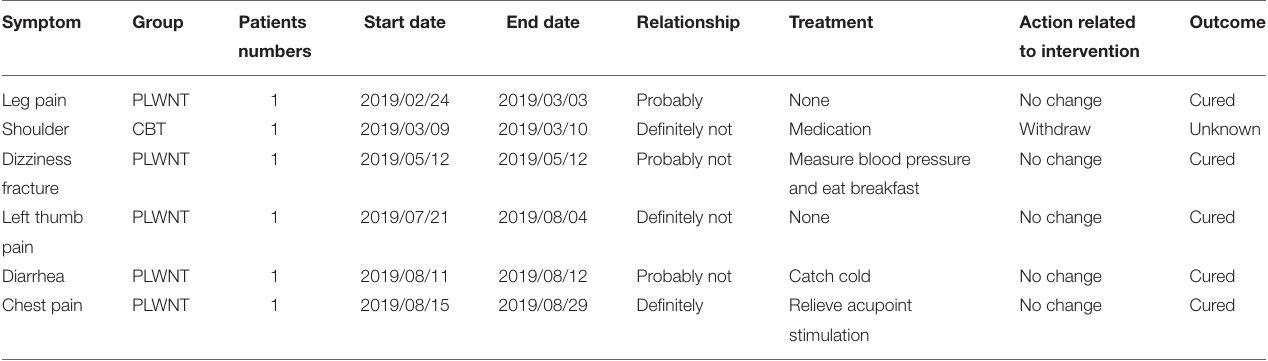
TABLE 5 | Adverse